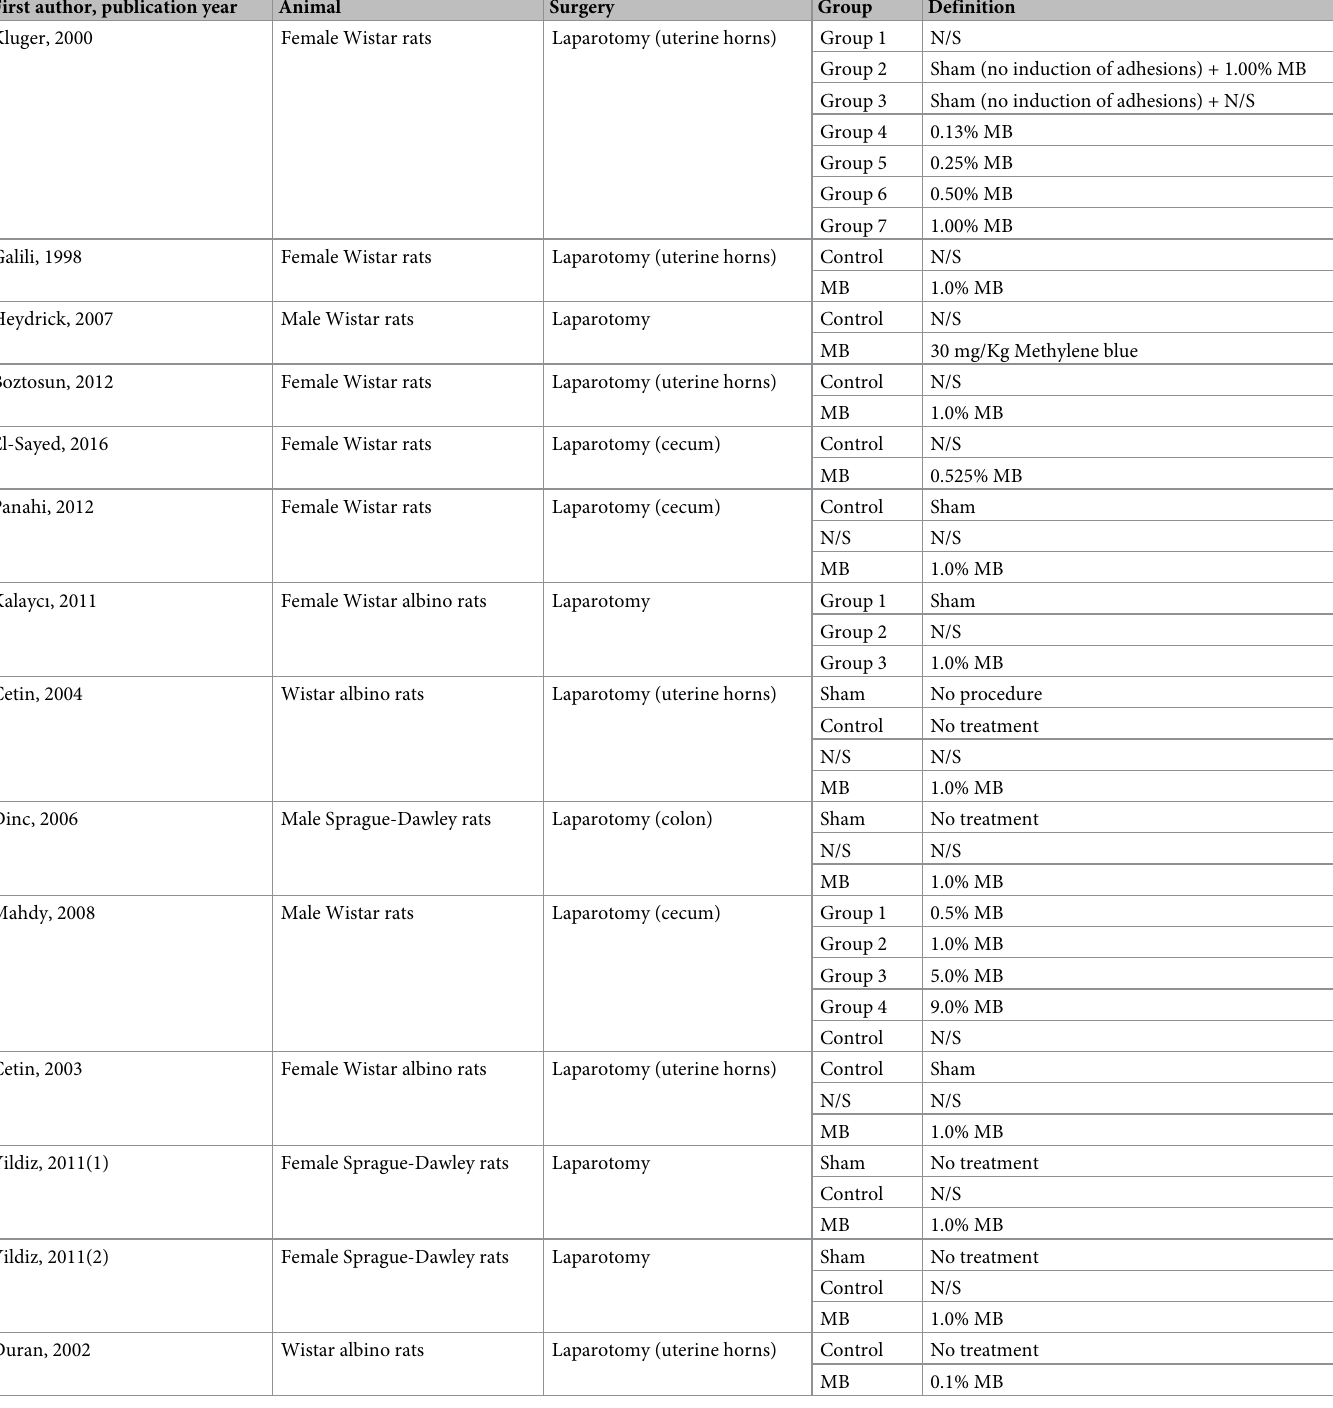
Table 1. Characteristics of included